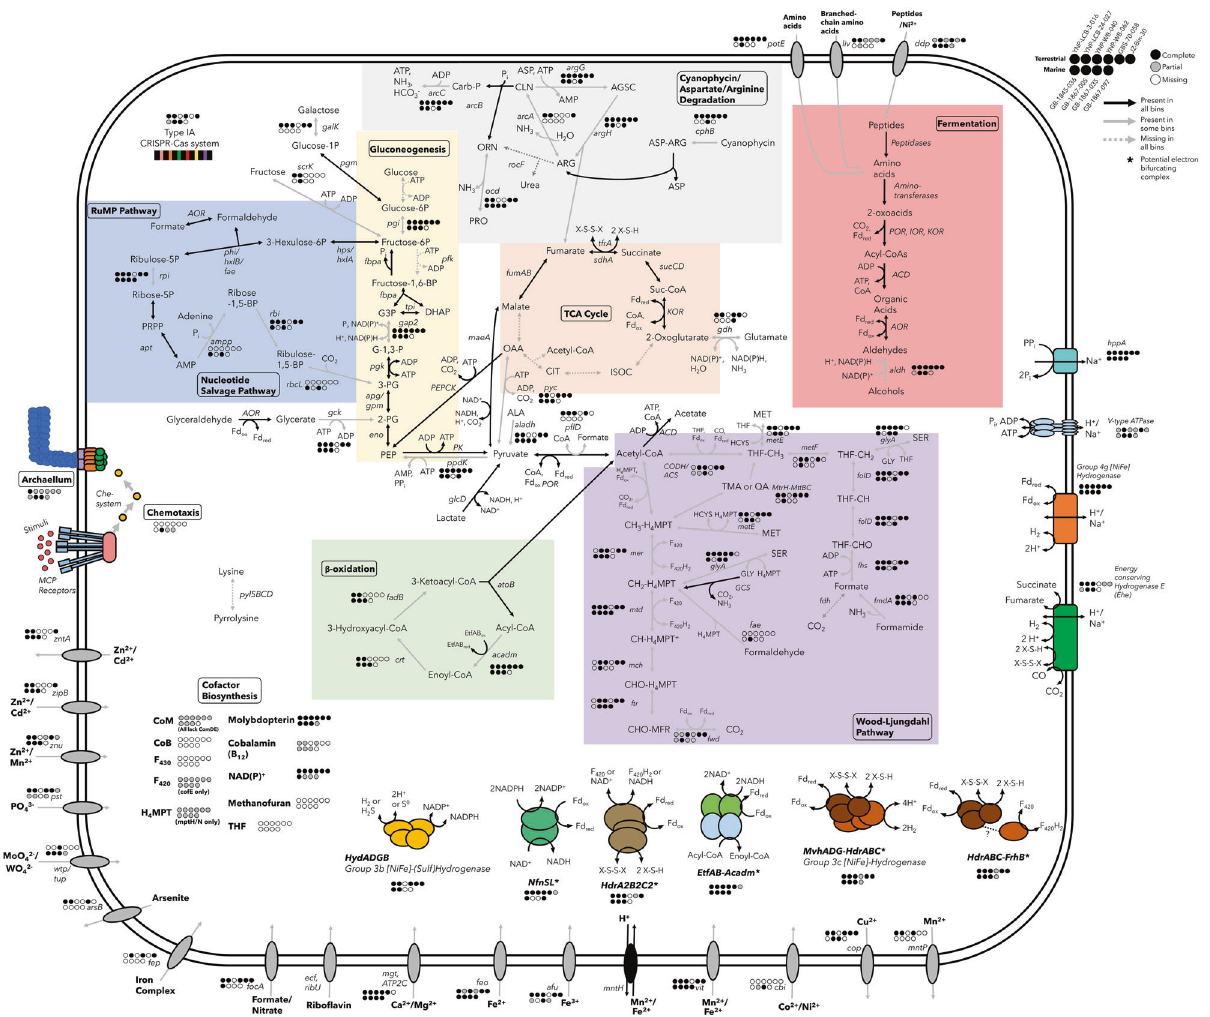
Fig. 3 Metabolic potential of Culexarchaeia MAGs. Solid black arrows indicate presence in all bins, solid gray arrows indicate presence in some bins, and dashed gray arrows indicate absence in all bins. For multi-subunit complexes and genes present only in some bins (solid gray arrows) — full presence, partial presence, and absence are shown with solid black circles, solid gray circles, and solid white circles respectively. A full list of genes used to construct this fi gure, gene IDs for each bin, and abbreviations can be found in Supplementary Files 3 and 4. Enzyme complexes with unclear annotation or association are indicated with ‘ (?) ’ . Asterisks (*) indicate potential electron-bifrucating